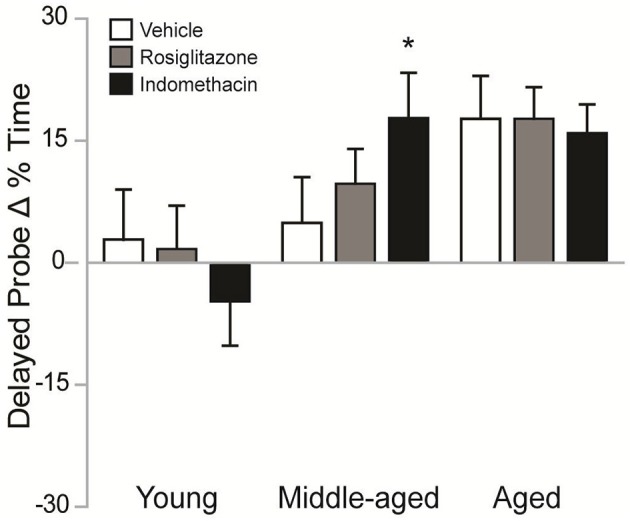
Indomethacin improved difference scores in middle-aged rats. Mean (± S.E.M.) differences in % Time spent in the target quadrant on the 2nd vs. 1st session are shown for rats treated with vehicle (white), rosiglitazone (gray), or indomethacin (black). Middle-aged indomethacin-treated rats exhibited bigger improvements in the % time spent in the target quadrant across sessions than middle-aged vehicle-treated rats (*p < 0.05). Although, rosiglitazone-treated aged rats (p < 0.05) and indomethacin-treated middle-aged and aged rats (p < 0.01) exhibited higher difference scores than young rats within each drug group, the unexpectedly poor delayed probe trial performances exhibited by young rats made interpretation of the effects of age within drug treatment difficult.